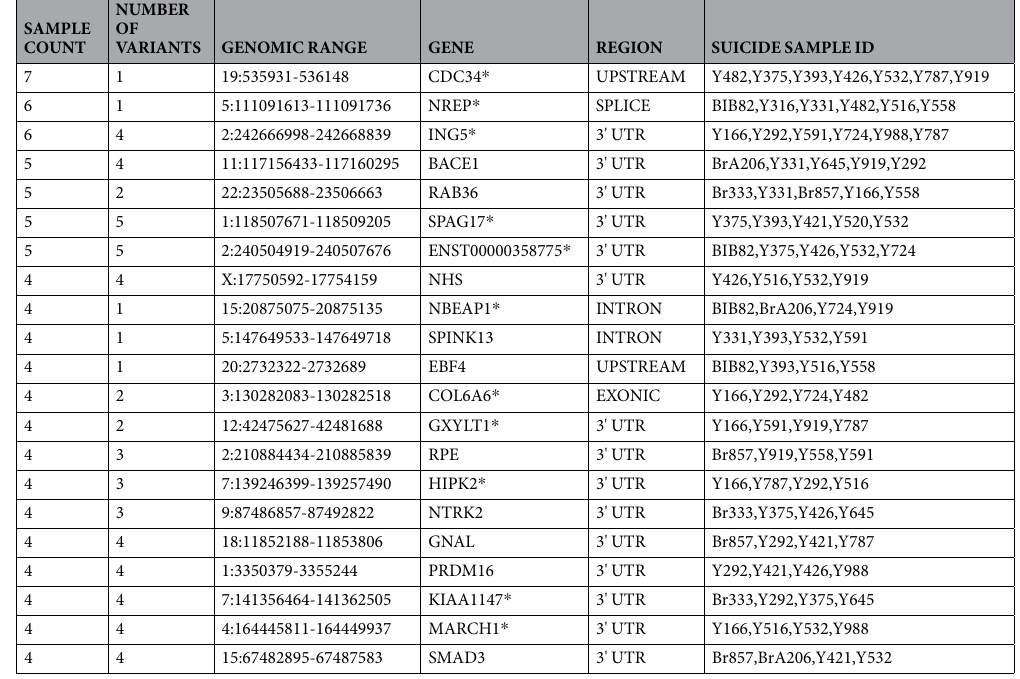
Table 1. Genomic region-dependent accumulation of rare variants in suicide samples.This table lists the genomic regions in which at least 4 suicide samples had rare variant(s). The SAMPLE COUNT column contains the number of suicide victims with rare variants in the same gene, the NUMBER OF VARIANTS column contains the number of individual variants within the gene, the GENOMIC RANGE column shows the GRCh37 start/end coordinates of the region, the GENE column contains the name of the gene, the REGION column contains the type of the genomic region, the SAMPLE ID column contains the suicide sample IDs with the rare variant in the given genomic regions. * denotes genes without disease association in MalaCards and